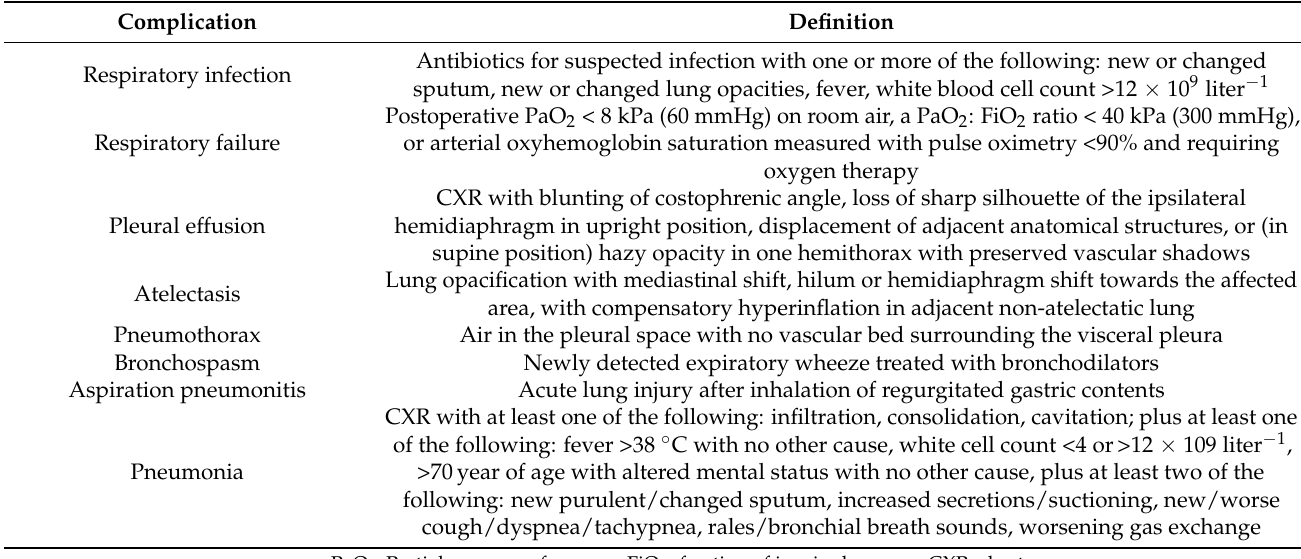
Table 1. Definitions of perioperative clinical outcomes for postoperative pulmonary complications [8].